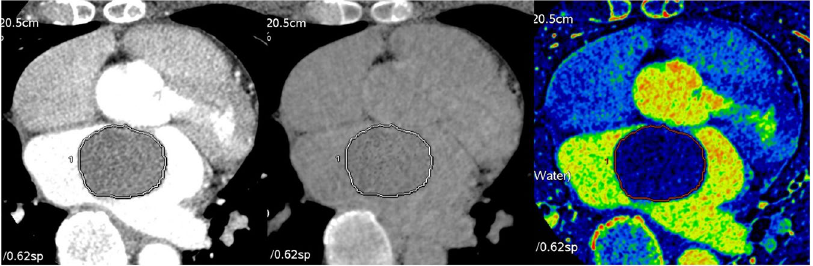
Figure 6. A representative image set for quantitative analysis of dual-energy CT of a cardiac tumor. Three modes of images were obtained using dual-energy CT: ( A ) a monochromatic 70 keV image representing the post-contrast CT image, ( B ) a MSI image representing the pre-contrast CT image, and ( C ) an iodine (water) image; A volume of interest covering the entire cardiac mass was drawn on the image of each mode on the identical level of the cardiac